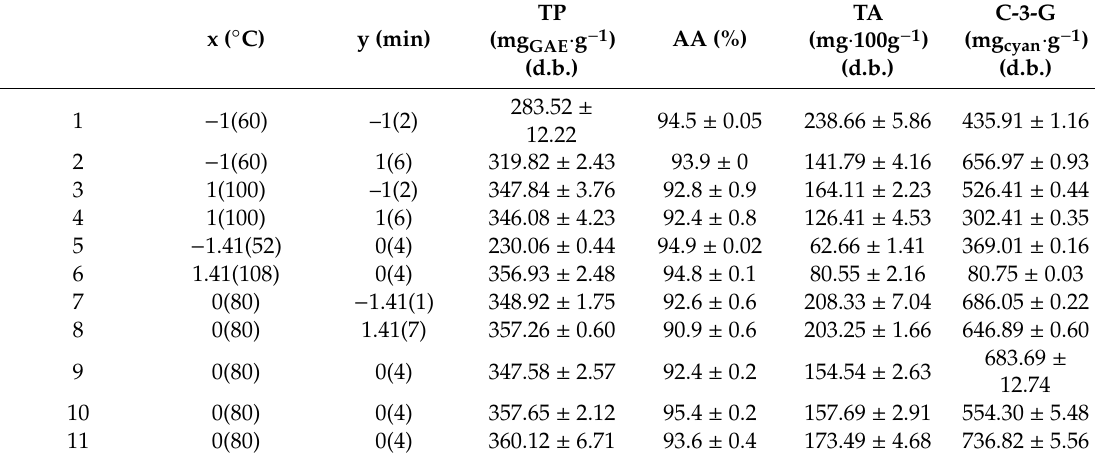
Table 1. Total phenolic content (TP), antioxidant activity (AA), total anthocyanin (TA), and cyanidin 3-glucoside (C-3-G) of the extracts obtained from jaboticaba